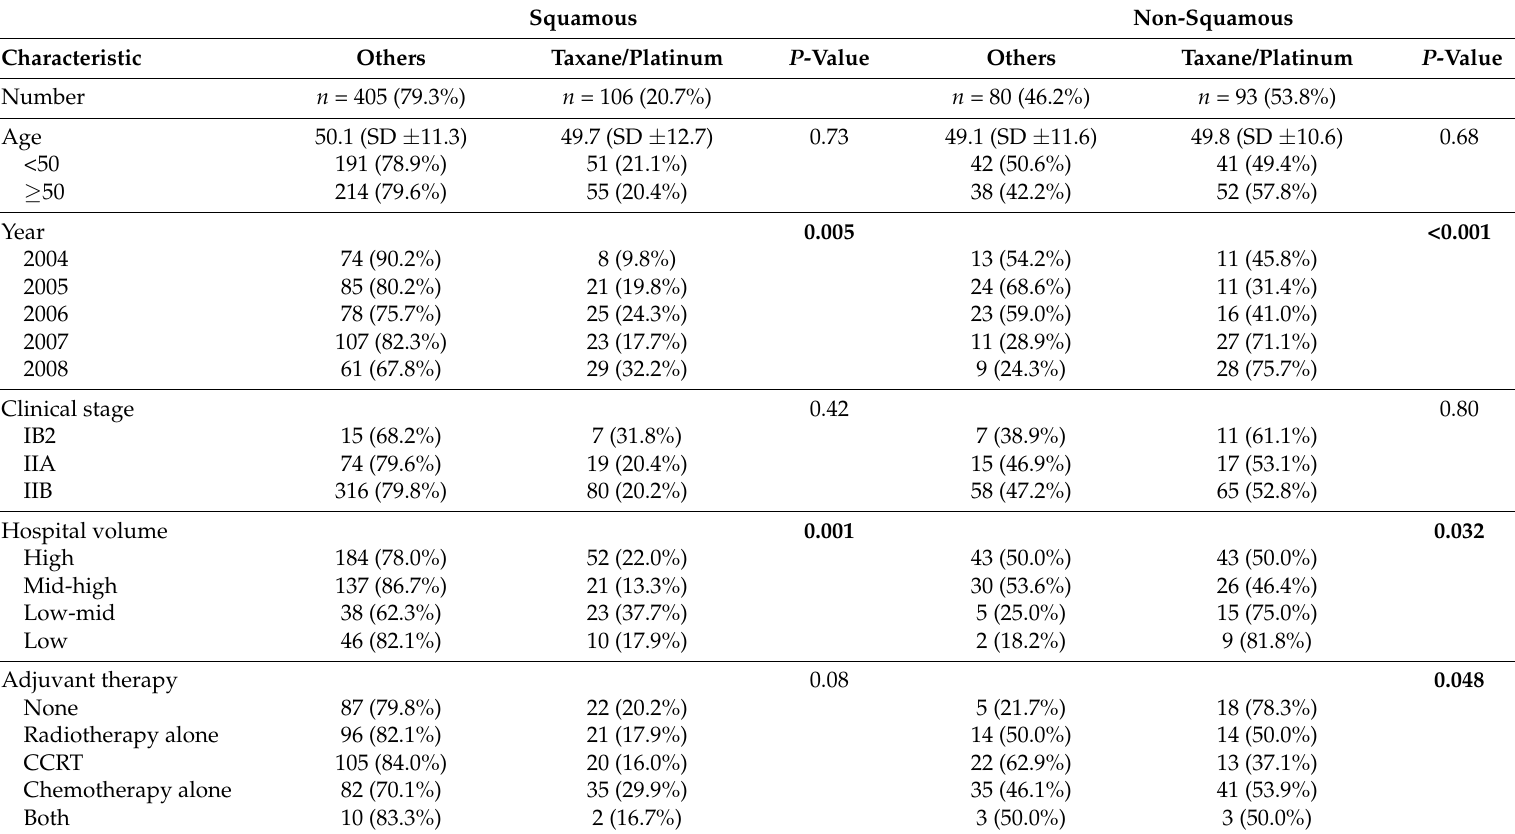
Table 2. Pretreatment characteristics per histology